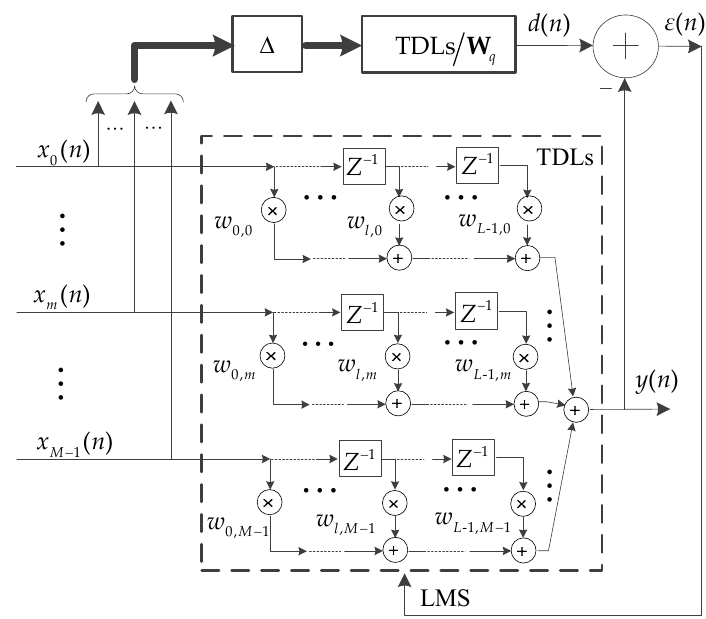
Figure 5. Schematic diagram of beam self ‐ steering.